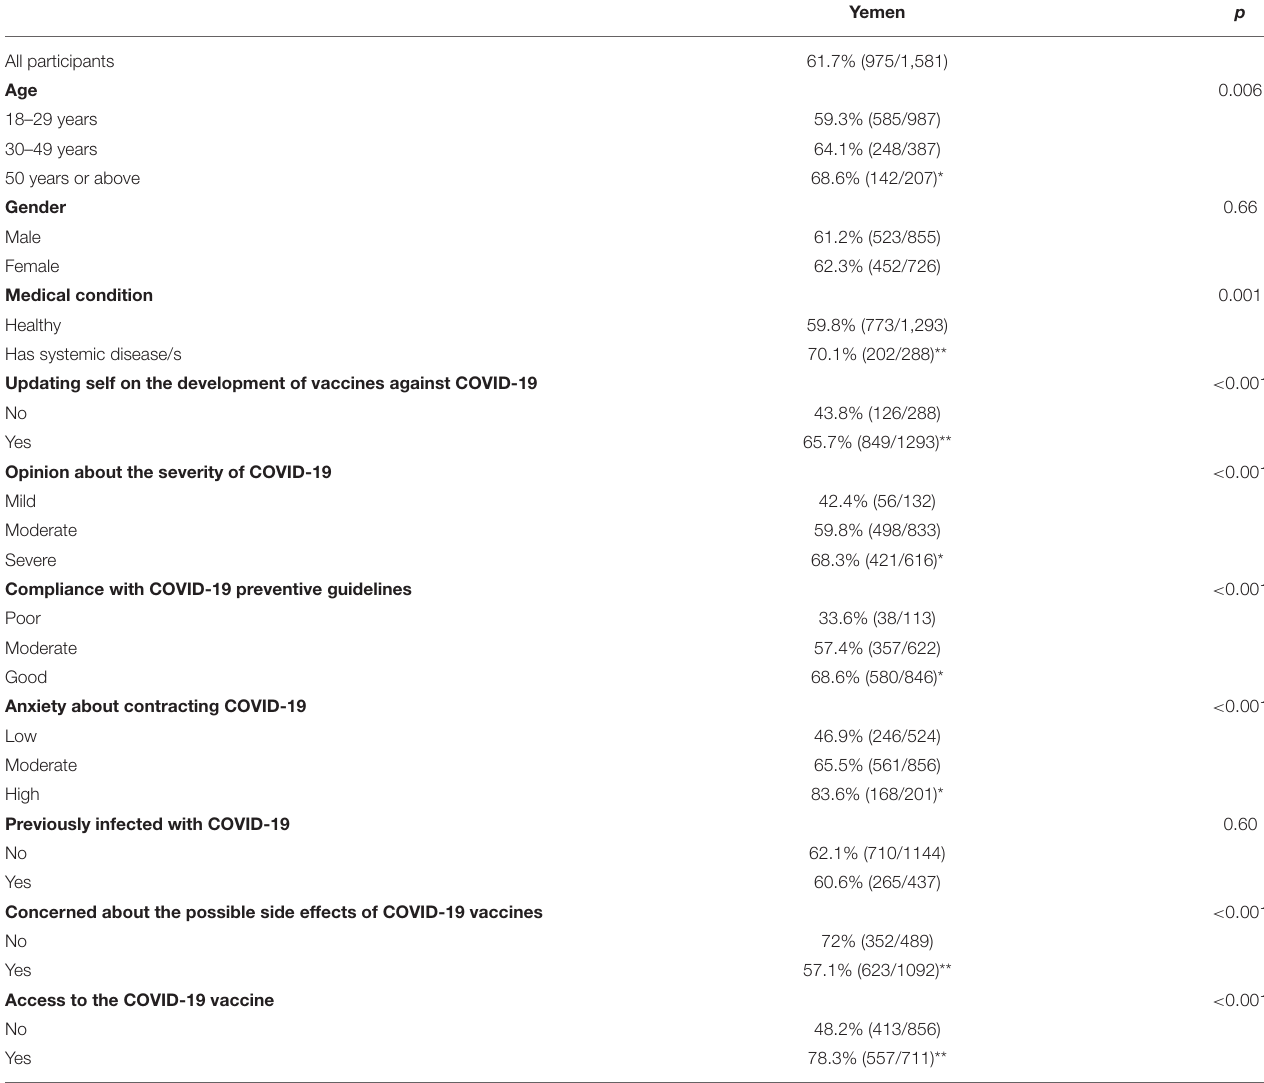
TABLE 4 | Bivariate statistical analysis of the relationship between the main outcome “intention to vaccinate” and potential influential